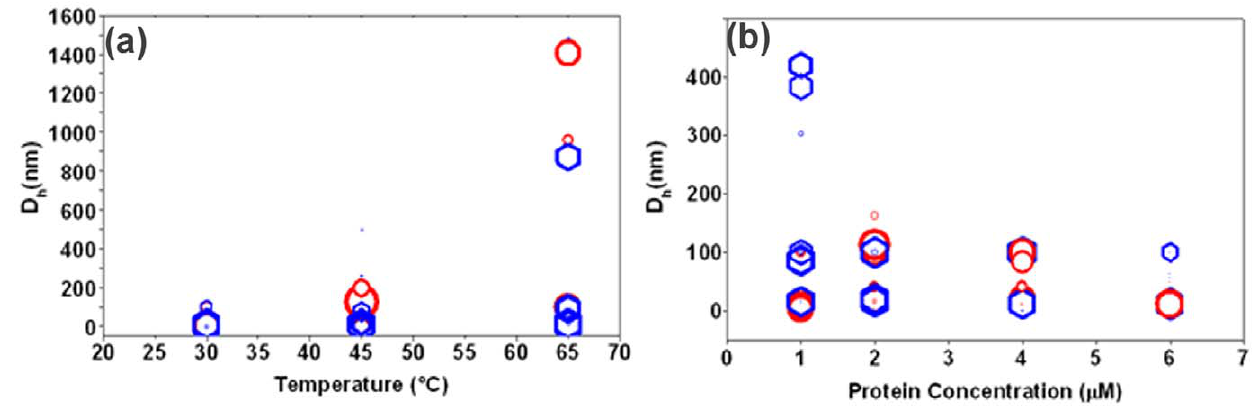
Figure 4. Variability in the size distribution of actin and MamK filaments. Hydrodynamic diameters of MamK (red circles) and actin (blue hexagonals) were measured as a (a) function of concentration (at 1, 2, 4 and 6 m M) and (b) temperature (at 30, 45 and 65 u C). Bubble diameters are proportional to the percentage of particles (weighted by intensity) with the respective D h values. The polydispersity index (PDI) that measures the distribution of molecular mass calculated as the ratio weight average molecular weight to the number average molecular weight , 1.0.